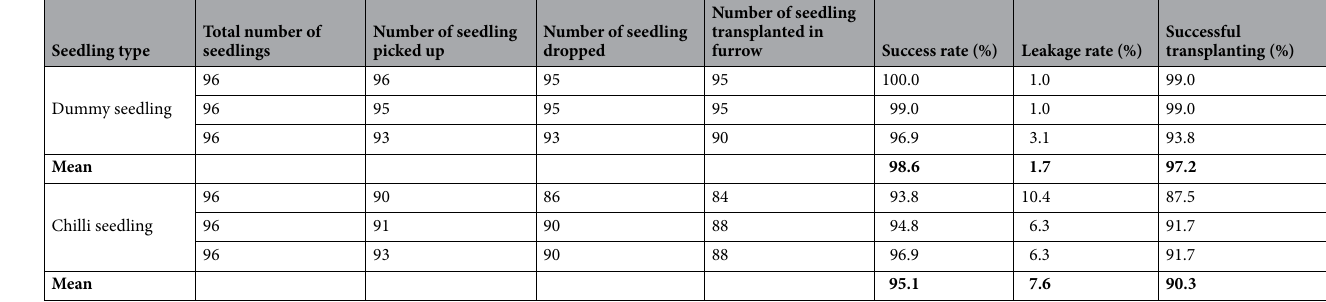
Table 3. Test performance of the developed robotic transplanter. Significant values are in